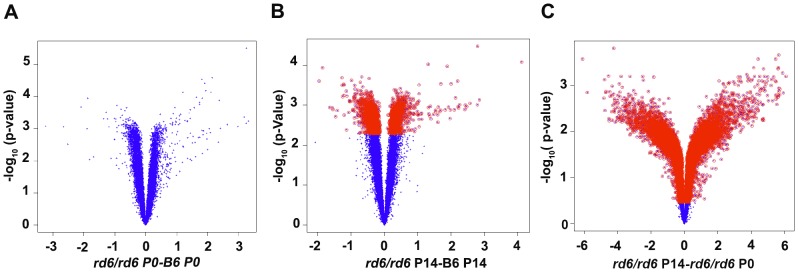
Volcano plots showing the relationship between fold change (represented as mean A – mean B) and the level of significance (represented by the Fs permutated p-value).Differentially expressed probe sets (q<0.05 shown in red across all fold change levels) at and fold change greater than 2 are depicted in volcano plots in three pairwise comparisons. (A) rd6/rd6 (Mfrprd6/Mfrprd6) P0 vs B6 (C57BL/6J) P0, (B) rd6/rd6 P14 vs B6 P14 and (C) rd6/rd6 P14 vs rd6/rd6 P0.